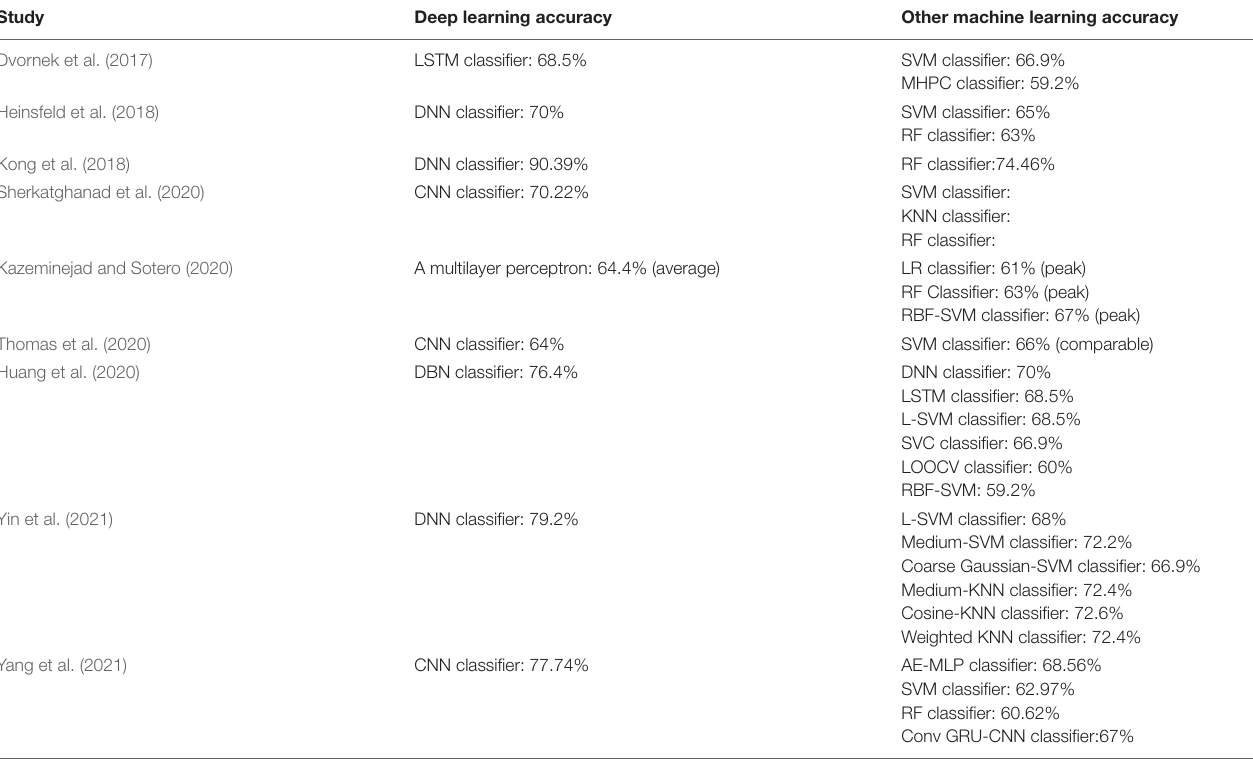
TABLE 2 | Accuracy comparison between deep learning and other machine